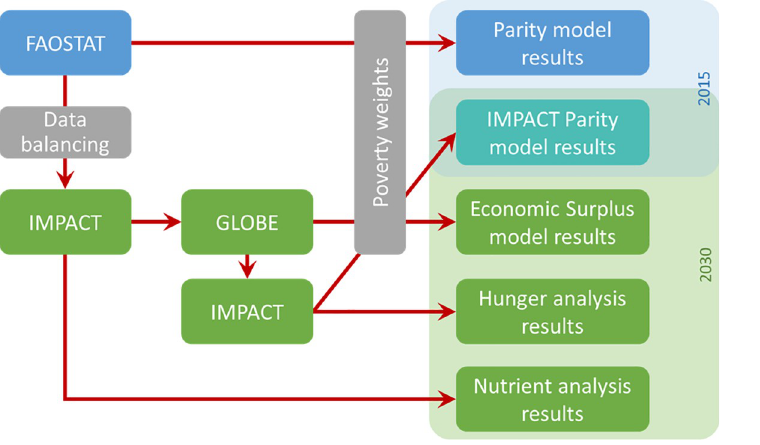
Fig 1. Summary of methods used. Source: The authors.